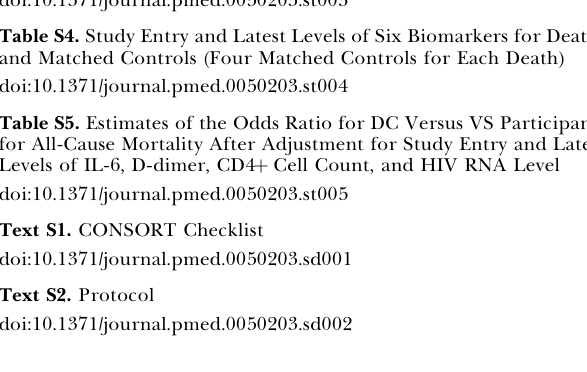
Table S3. Risk of Death Associated with Biomarker Levels at Baseline—Four Controls Per Death Table S4. Study Entry and Latest Levels of Six Biomarkers for Deaths and Matched Controls (Four Matched Controls for Each Death) Table S5. Estimates of the Odds Ratio for DC Versus VS Participants for All-Cause Mortality After Adjustment for Study Entry and Latest Levels of IL-6, D-dimer, CD4 þ Cell Count, and HIV RNA